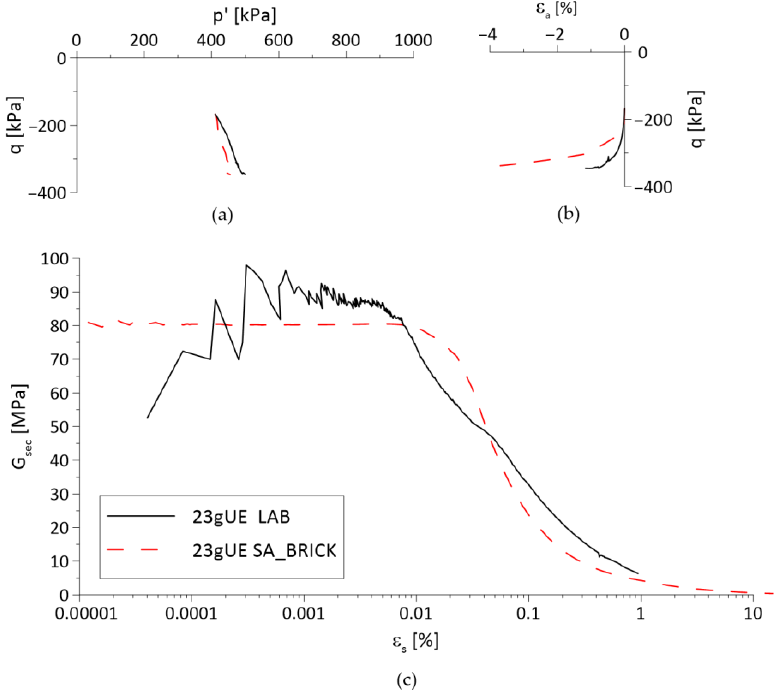
Figure 9. Validation of the SA_BRICK model against laboratory sample 23gUE [47]: ( a ) q – p ′ diagram; ( b ) q – ε a diagram; ( c ) G sec – ε s diagram.